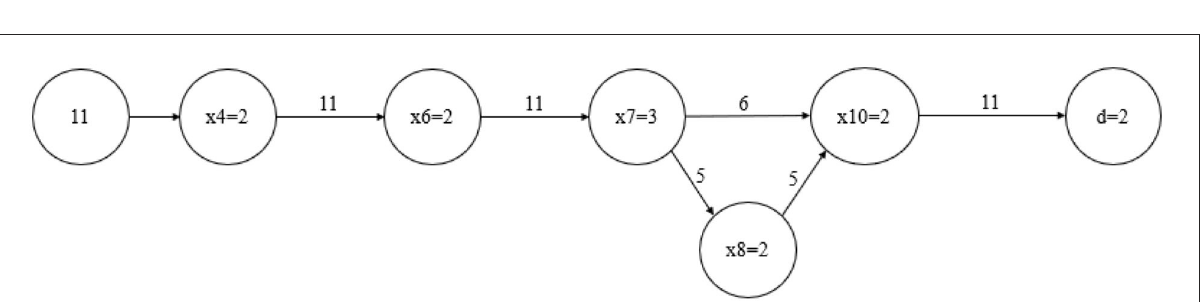
FIGURE3 Decision flow graph and rule-set of medium intention to use GMFs class. x4 = 2 means that consumer is self-employed; x6 = 2 means that consumer’s perception of CSR is medium; x7 = 3 means that consumer’s concerns about GMFs is high; x8 = 2 means that consumer’s promotion focus toward GMFs is medium; x10 = 2 means that consumer’s autonomy to choose GMFs is medium; d = 2 means that consumer’s intention to use GMFs is